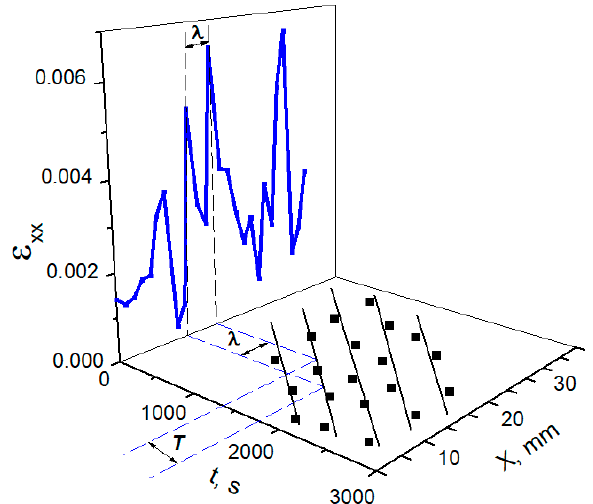
Figure 2. The distribution of local elongations ε xx , observed for the sample midline, and the X − t diagrams for measuring λ and T values.